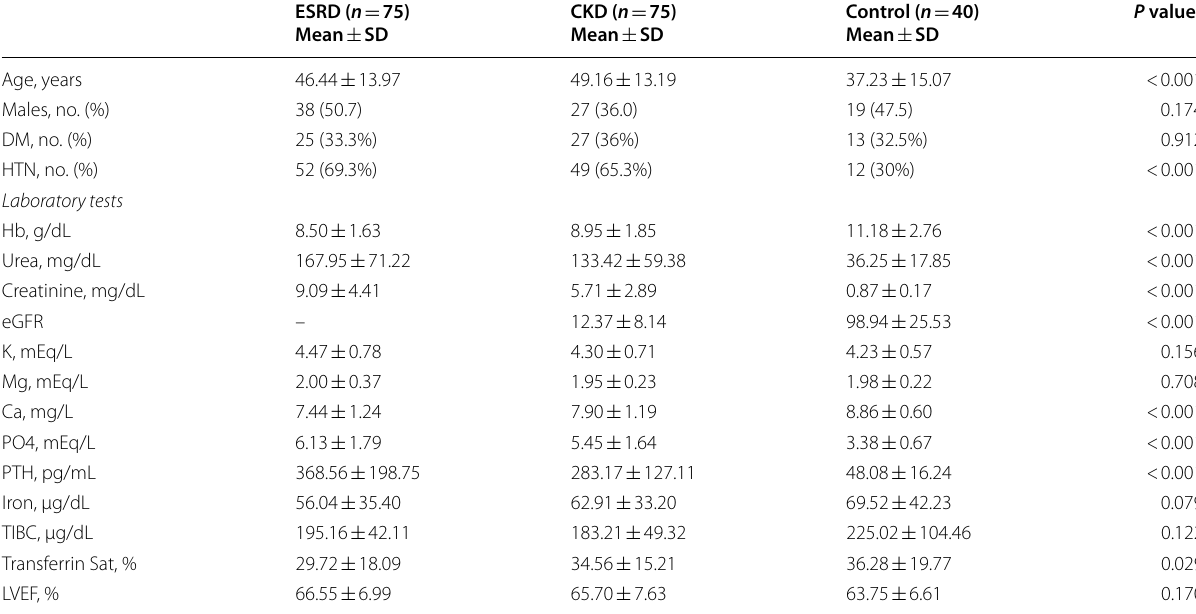
Ca, Calcium; DM, Diabetes Mellitus; eGFR, Estimated Glomerular Filtration Rate; Hb, Hemoglobin; HTN, Hypertension; K, Potassium; LVEF, Left Ventricular Ejection Fraction; Mg, Magnesium; PO4, Phosphorus; PTH, Parathyroid hormone; TIBC, Total Iron Binding Capacity Table 2 Electrocardiography parameters of the study population Max, maximum; Min, minimum; P-WD, P wave dispersion; QTc, Corrected QT interval; Tp-e, T wave peak to end